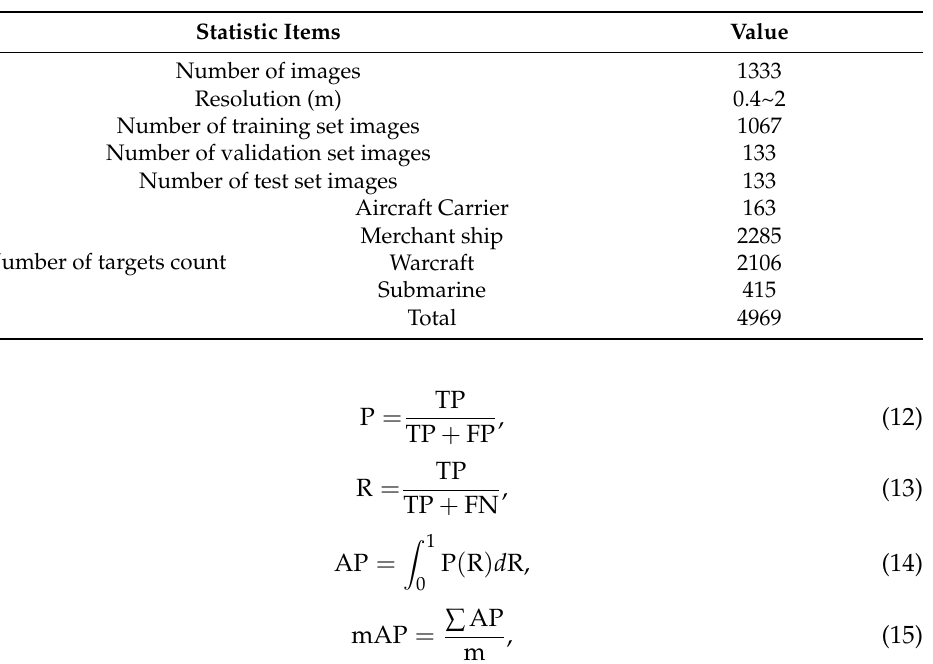
Table 1. Dataset details.